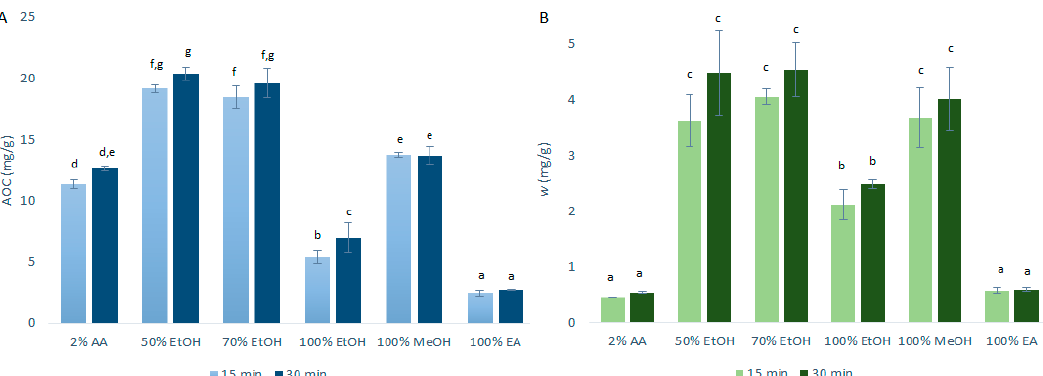
Figure 2. Quercetin equivalent antioxidant capacity (AOC) ( A ) and mass fraction (w) of quercetin ( B ) for the time courses of the primary extractions using ultrasound-assisted extraction with the different solvents at 1:10 mass-to-liquid ratio and 25 °C. Data are expressed as mg quercetin per g dry matter, as means ±standard deviation. Different letters within each histogram indicate significant differences ( p < 0.05; ANOVA). AA, acetic acid; EtOH, ethanol; MeOH, methanol; EA, ethyl acetate.